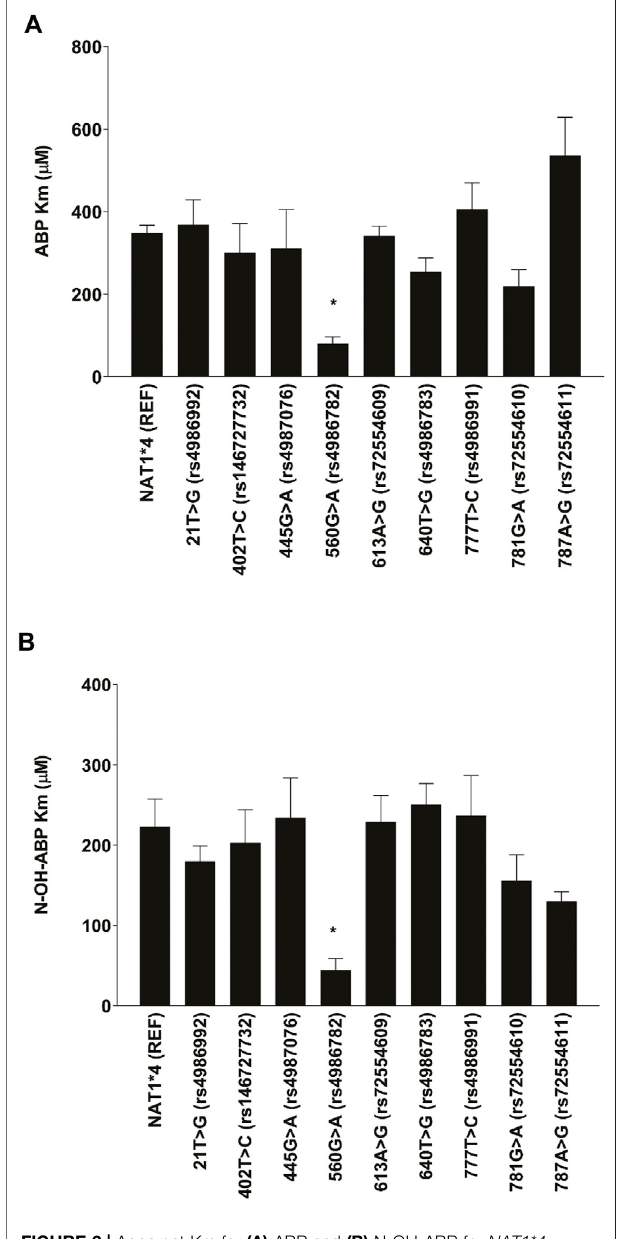
FIGURE 1 | Apparent Vmax for (A) ABP N-acetylation and (B) N-OH- ABP O-acetylation for NAT1*4 (reference) and NAT1 variants possessing the SNP labeled on the abscissa. Each bar represents Mean ± SEM from three transfections in duplicate. *Signi fi cantly less than NAT1*4 for ABP-N- acetylation ( p ≤ 0.001) and N-hydroxy-ABP O-acetylation ( p < 0.05).